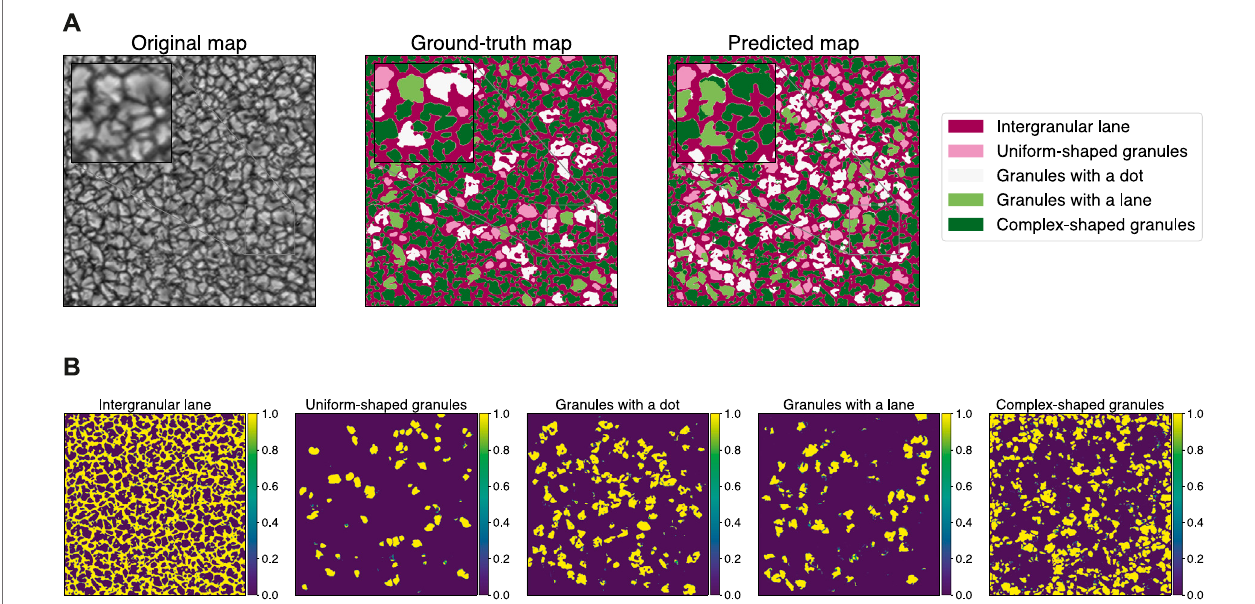
FIGURE 5 | (A) Comparative maps using the validation full size map – Test 2: U-net model using Mean IoU as training loss function. A zoomed region is highlighted showing in detail the diverse constrains of the segmentation. (B) Probability maps per class using the validation full size map – Test 2: U-net model using Mean IoU as training loss function.